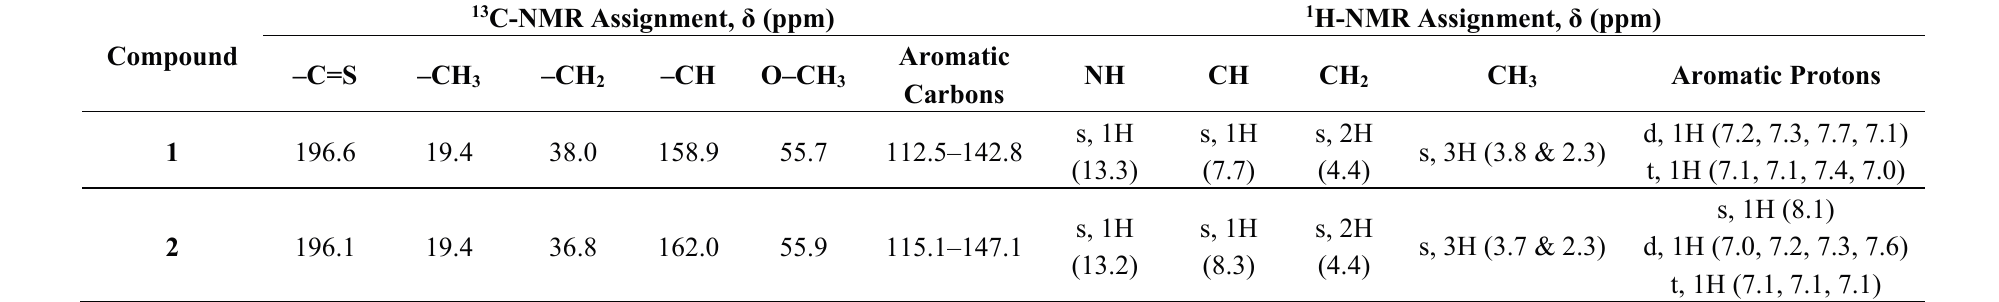
Table 2. 13 C-NMR and 1 H-NMR spectral data for compounds 1 and 2